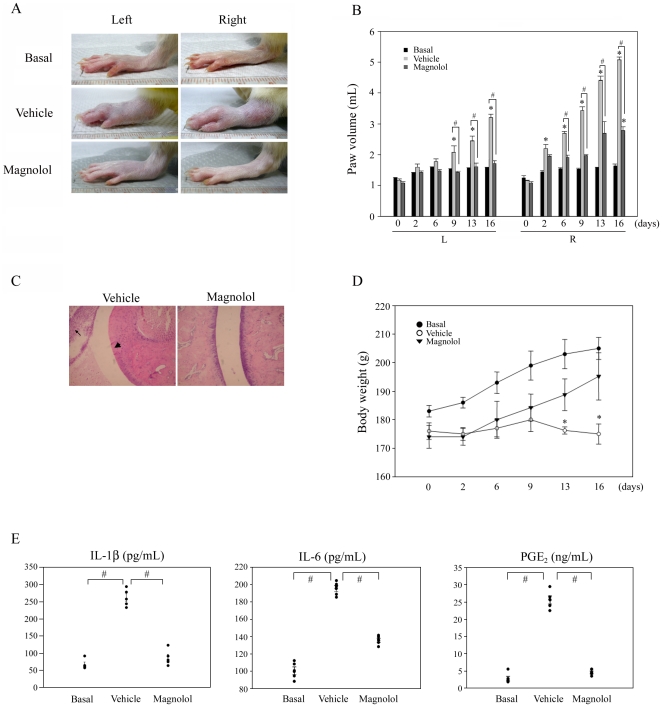
Magnolol suppresses arthritis development in an adjuvant-induced arthritis (AIA) model.After onset of arthritis, rats were treated with 100 mg/kg magnolol or vehicle (on day 2) for a total of 14 days. (A) Swelling of the ankle joints of both paws were markedly suppressed by treatment of arthritic rats with 100 mg/kg magnolol, as compared to the vehicle group. (B) Both hind paw volumes of non-treated (basal) rats, vehicle-treated, and magnolol-treated rats were measured using a digital plethysmometer on the indicated day after AIA induction. (C) Hematoxylin and eosin staining of tissue specimens from the left ankle joints of vehicle-treated rats and magnolol-treated rats. The specimen from a vehicle-treated rat exhibits severe synovitis (arrowhead) and leukocyte (arrow) infiltration. Magnolol treatment inhibited both effects. (D) Body weight of non-treated (basal) rats, vehicle-treated, and magnolol-treated rats measured on the indicated day after AIA induction. (E) Quantification of cytokines in sera by ELISA on day 16. In (B) and (D), the results are expressed as the mean ± standard error of the mean (SEM), with n = 5. * p<0.05 compared to the control group; #p<0.05 for the comparison of the indicated groups.